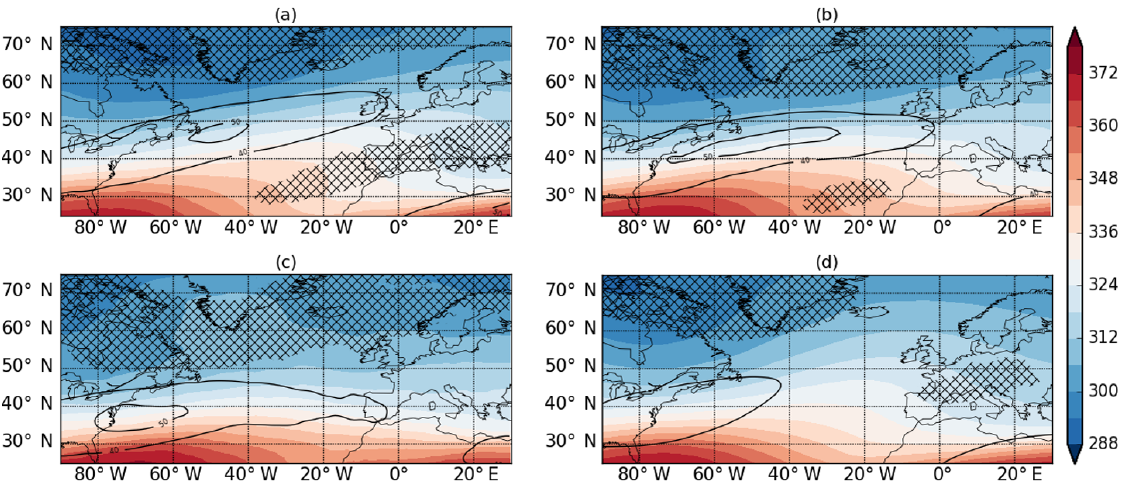
Figure A1. Composites of clustered days from ERA-Interim at (a) 65 ◦ N, (b) 55 ◦ N, and (c) 45 ◦ N. (d) Climatology. Contours and hatching are the same as Fig. 2.